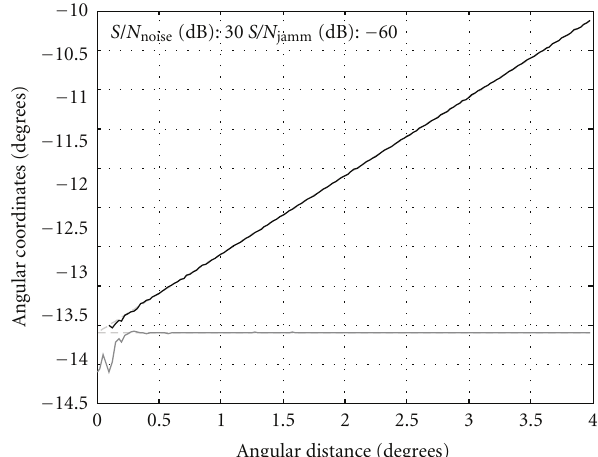
Figure 11: Histogram of polar coordinates evaluated by using the ESPRIT method at S/N noise = 30dB and S/N jamm = − 60dB.